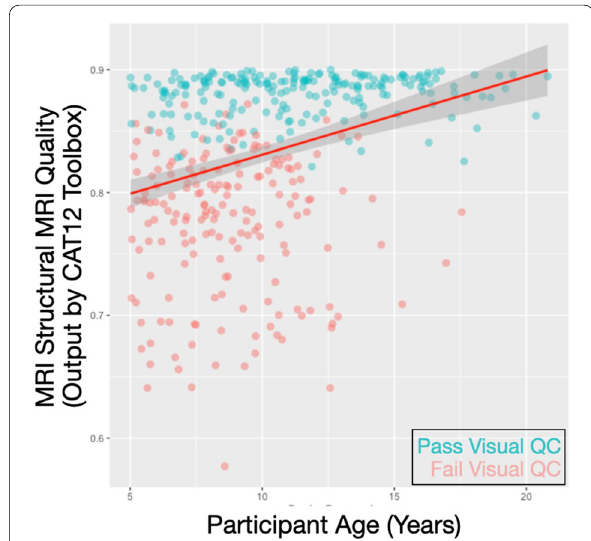
Fig. 4 Scatterplot showing participant age (in years; horizontal axis) and image quality (an aggregated measure of noise-to-contrast ratio, coefficient of joint variation, inhomogeneity-to-contrast ratio, and root-mean-squared voxel resolution, ranging from 0–1; vertical axis). Dot color indicates whether the participants passed visual quality checks (pass turquoise; fail salmon) = =